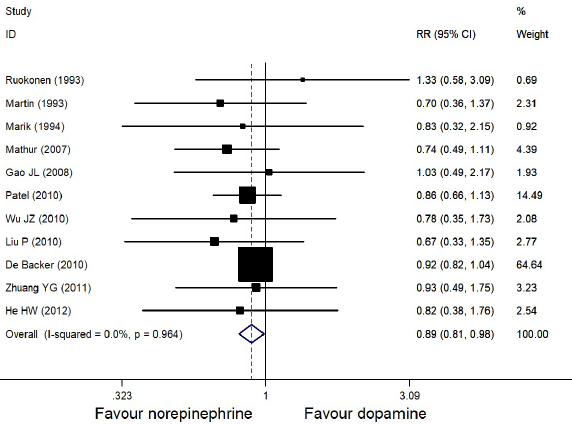
Figure 2: The forest plot of relative risk of death for norepinephrine versus dopamine in treatment of septic shock.